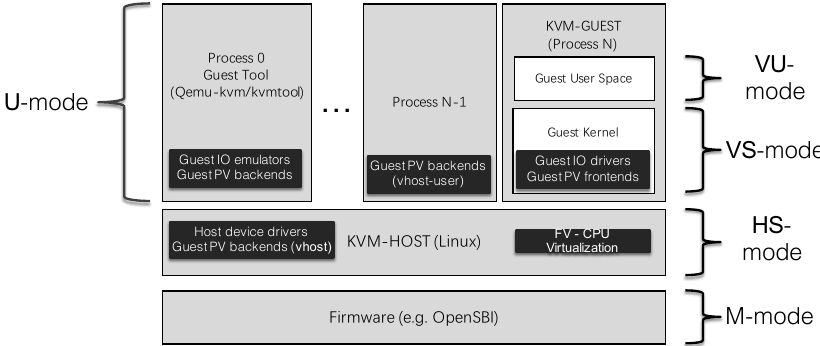
Figure 4. KVM on RISC-V.